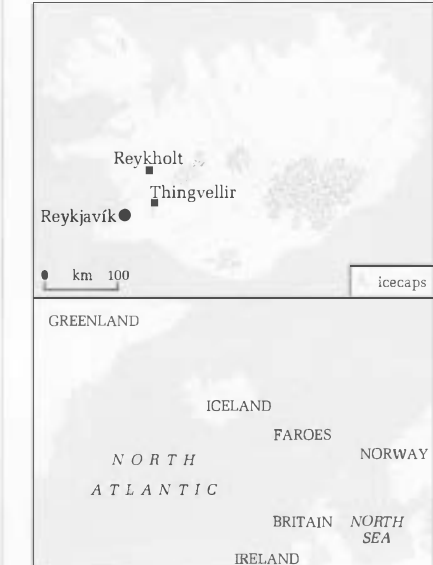
Figure 1 Iceland, showing the location of Reykholt and of the Althingi (the former parliament) at